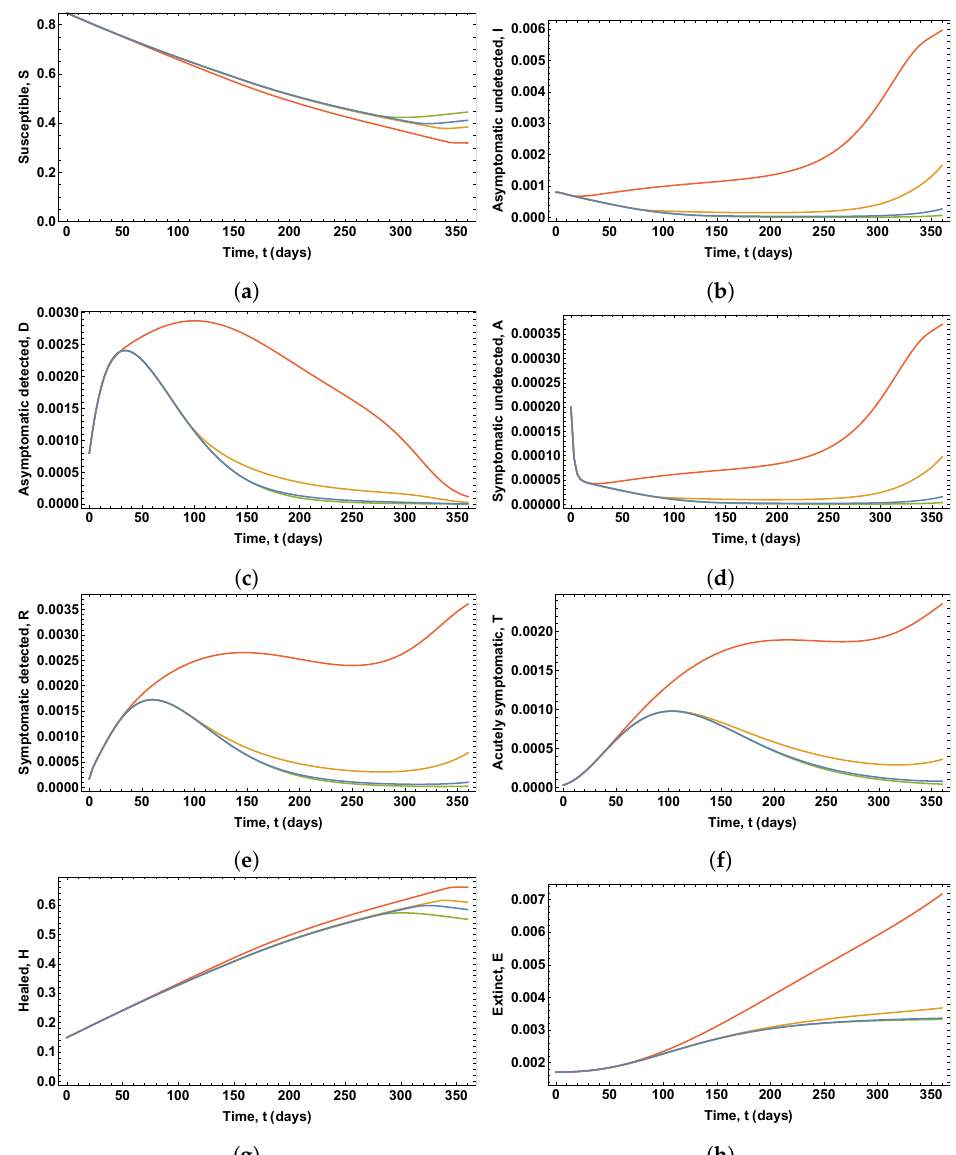
Figure 12. Proportions of people in each compartment obtained assuming C 3 = 1 (red), C 3 = 0.1 (orange), C 3 = 0.01 (blue), and C 3 = 0.001 (green), with fixed parameters C 1 = 1 and C 2 = 0.1: ( a ) Susceptible people. ( b ) Asymptomatic undetected people. ( c ) Asymptomatic detected people. ( d ) Symptomatic undetected people. ( e ) Symptomatic detected people. ( f ) Acutely symptomatic people. ( g ) Healed people. ( h ) Extinct